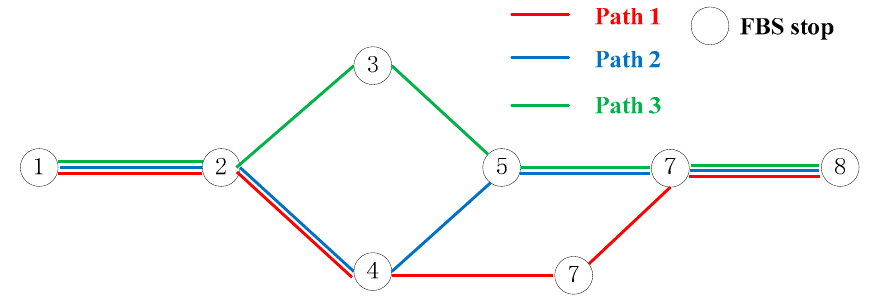
Figure 5. Topological structure of the network.